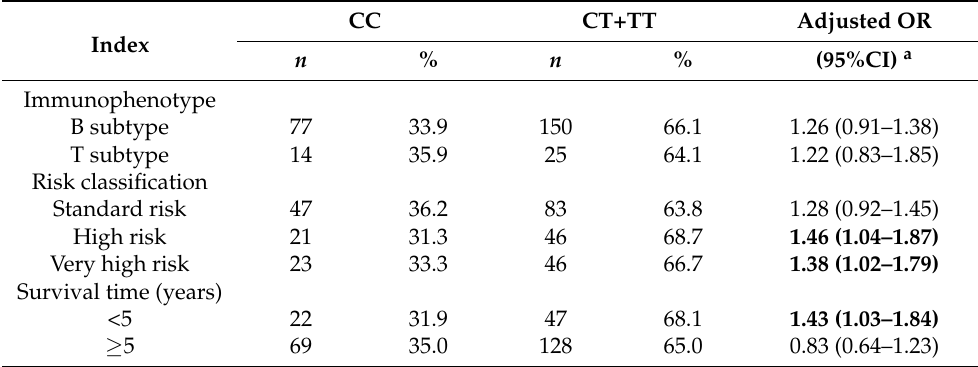
Table 6. Association between the H19 rs2839698 genotype with clinical index of childhood leukemia.